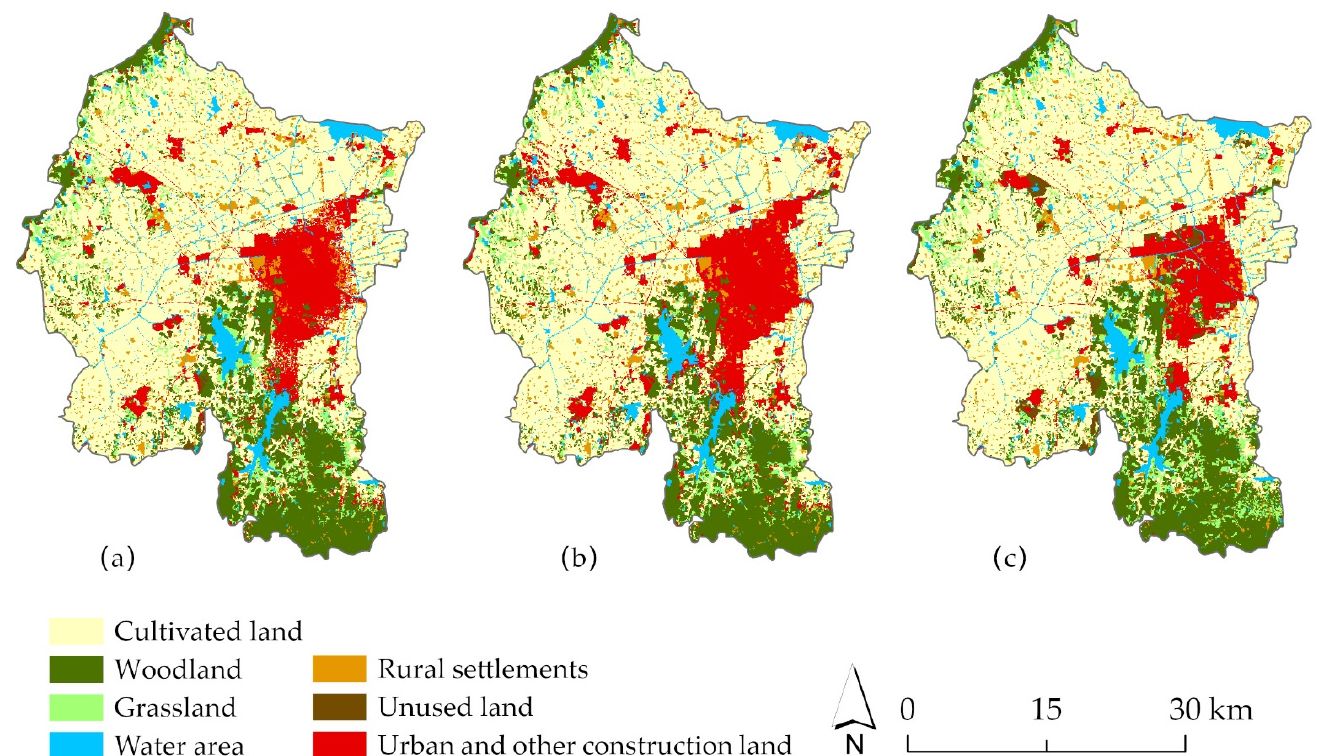
Figure 5. Results of land use simulation in 2030 under di ff erent scenarios. ( a ) NGS; ( b ) EDS; ( c ) EPS.